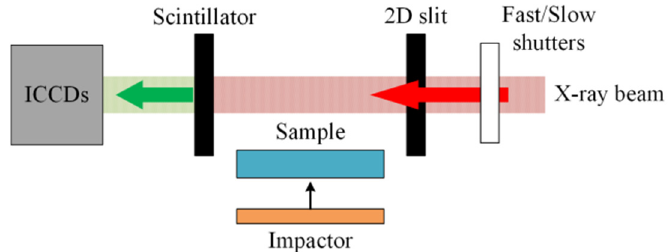
Figure 23. X ‐ ray diagnostic experimental